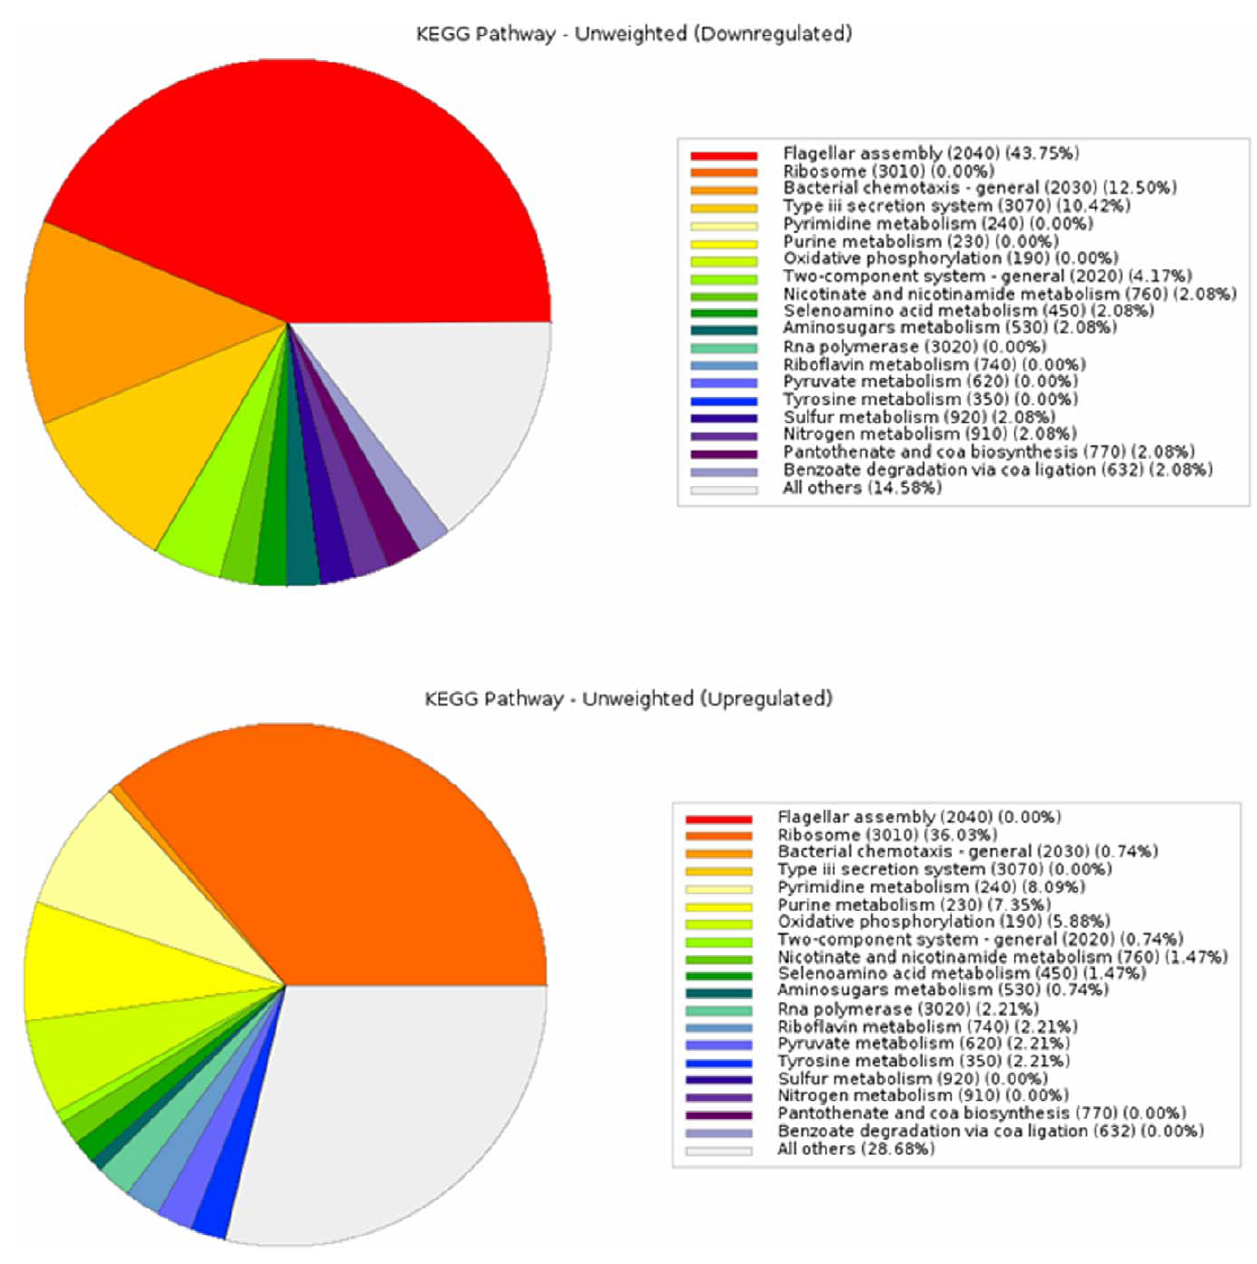
Figure 3. Up- and Down-regulated genes from attack-phase to predatory come from very different KEGG categories. Pie charts showing the very different category distributions, of significantly down regulated or up-regulated Bdellovibrio genes upon the shift from attack phase to 30 minutes predation. (Only genes that have KEGG categories are shown, organised by those categories). Type iii secretion system category refers only to flagellar genes as Bdellovibrio has no other Type III system).